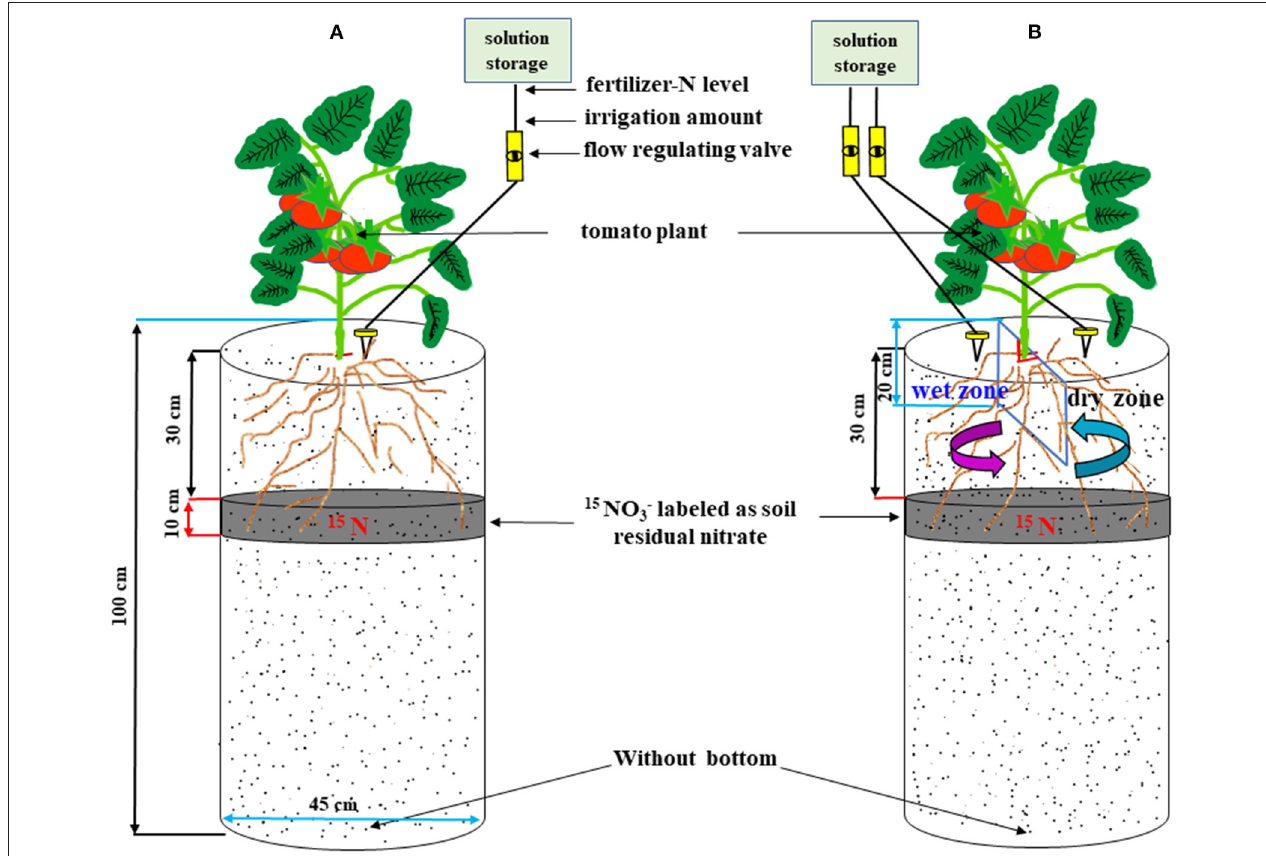
FIGURE 1 | The schematic view of the soil column design for conventional drip irrigation (A) and alternate partial root-zone drip irrigation (B)